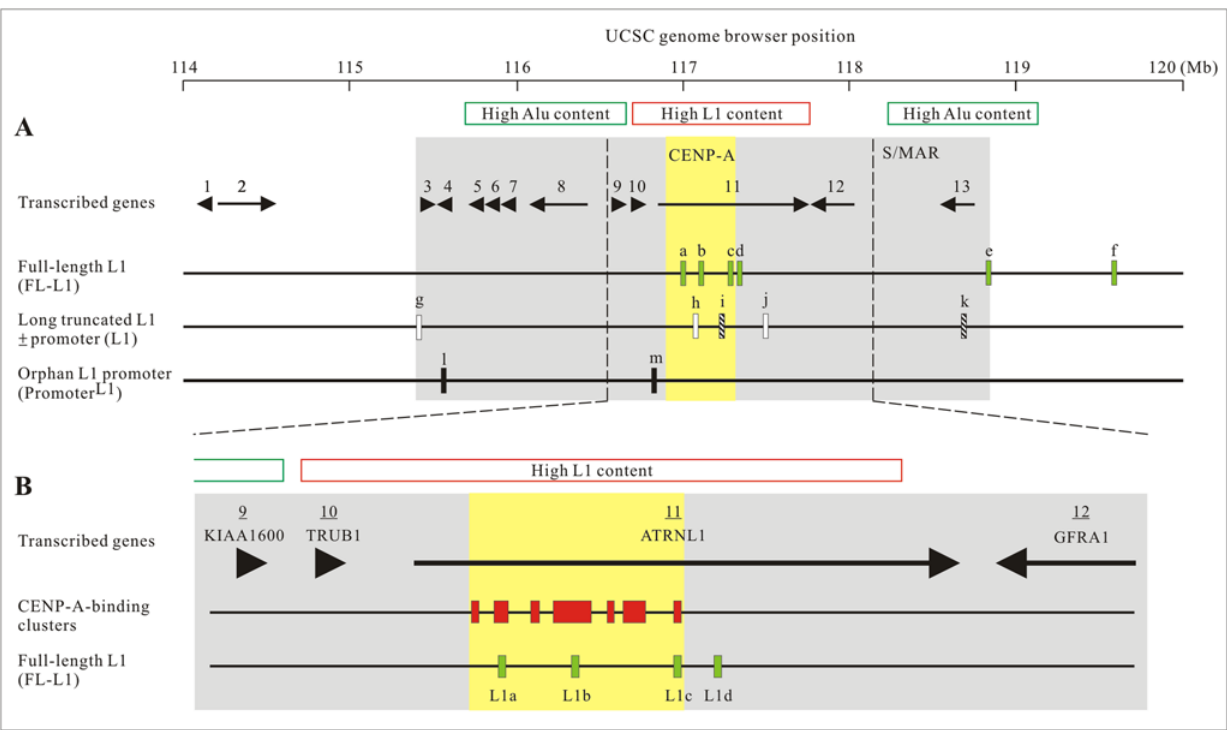
Figure 2. Distribution of FL-L1s, long truncated L1s, and orphan L1 promoters across a 6-Mb genomic region of the 10q25 neocentromere. (A) A total of six FL-L1s (green bars) were found, with a cluster of four of these elements (a–d) localizing within and near the CENP- A-binding region (shaded in yellow) [9]. Open bars denote long truncated L1s; hatched bars denote truncated L1s containing an internal promoter sequence; black bars denote orphan L1 promoter sequences. The positions of 13 transcribed genes (black arrows/arrowheads) are shown [17], of which 11 are found within the 3.5-Mb S/MAR domain (shaded in grey). (B) Close-up view of the CENP-A-binding and immediately surrounding region, showing the distribution of the seven CENP-A-binding clusters in relation to the ATRNL1 gene and FL-L1a–d. Note that FL-L1a–c reside within the CENP-A-binding clusters (red boxes) [18], with the actively transcribed FL-L1b being localized within the largest, central cluster.